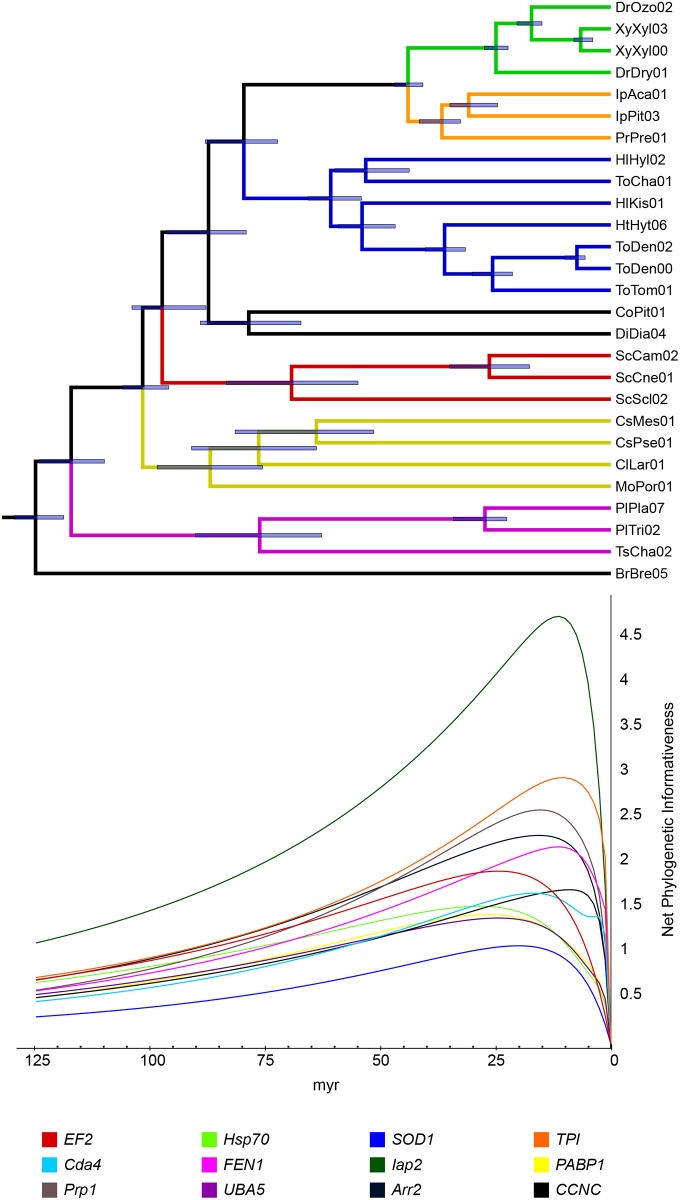
Phylogentic informativeness profiles.The K2P model was used to estimate substitution rates in HyPhy as implemented in the software PhyDesign. Different evolutionary models produced similar results (data not shown). The dated phylogenetic tree was obtained using BEAST v1.8.2.